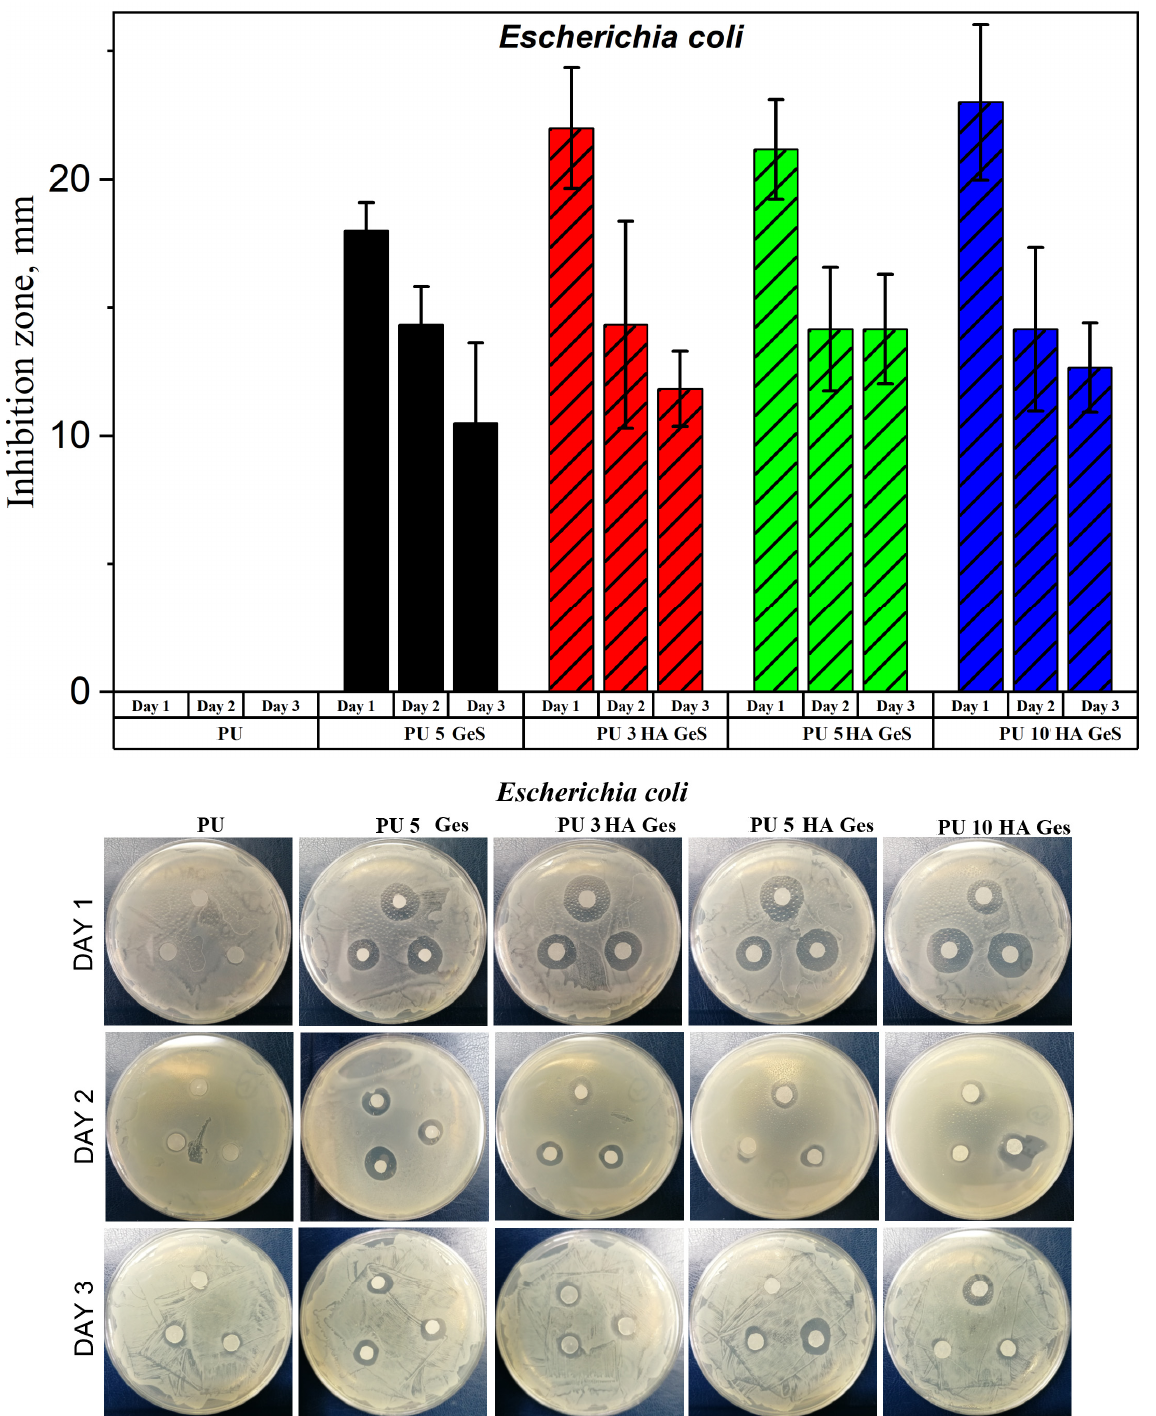
Figure 8. Inhibition zones of E. coli growth around nanocomposite-film discs.